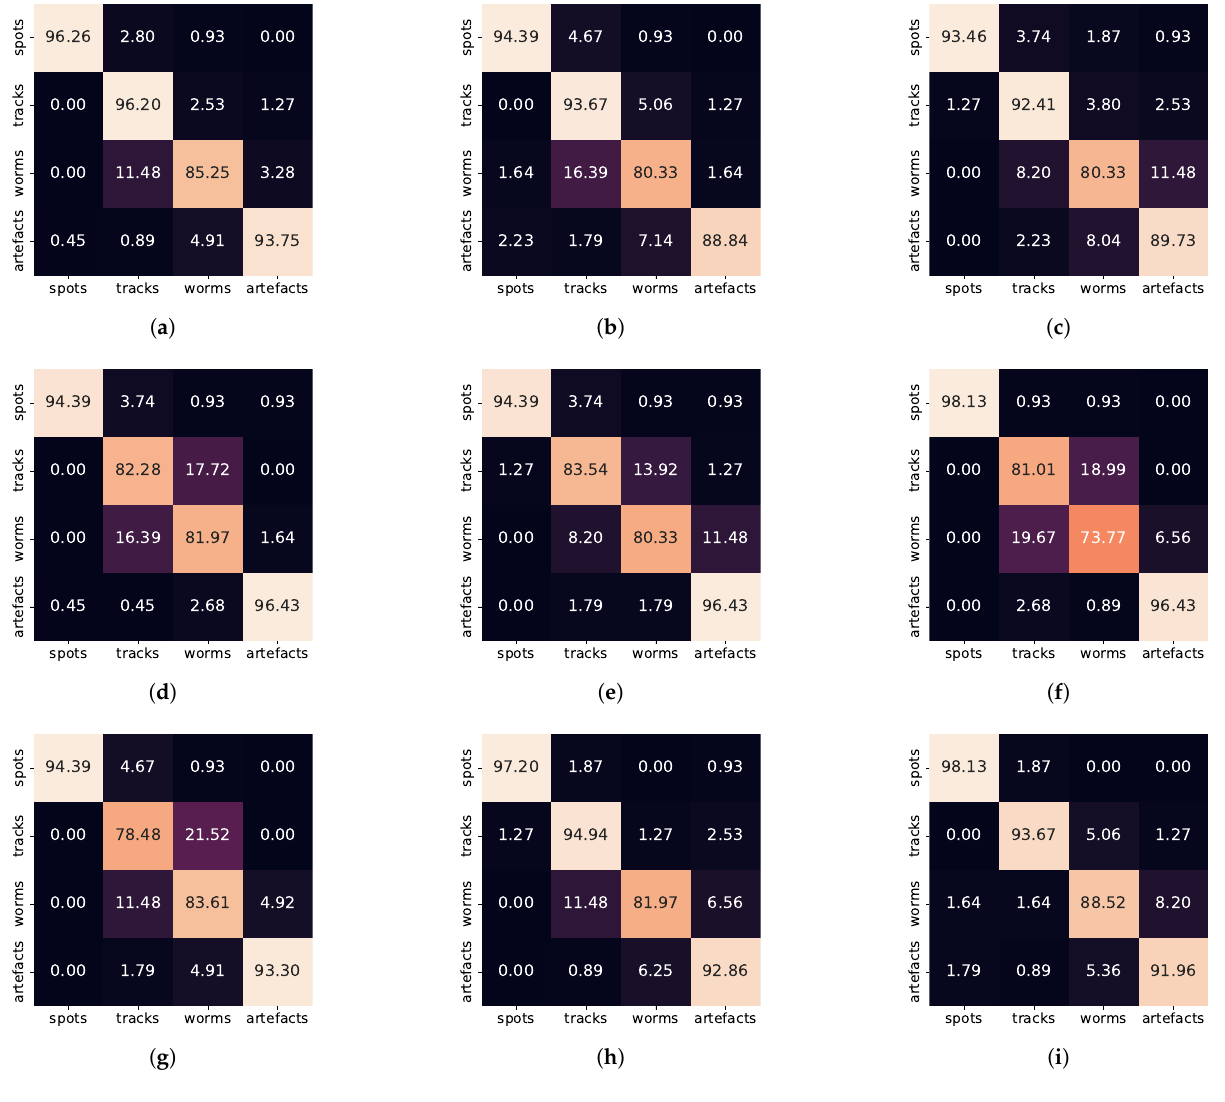
Figure 11. Confusion matrices for best performing simple classifiers: ( a ) MLP, ( b ) ν SV, ( c ) SVC and ensemble classi- fiers: ( d ) ETC, ( e ) GBC, ( f ) RFC, ( g ) bagged SVC, ( h ) SVC with one-vs-one multiclass strategy, ( i ) MLP with one-vs-rest multiclass